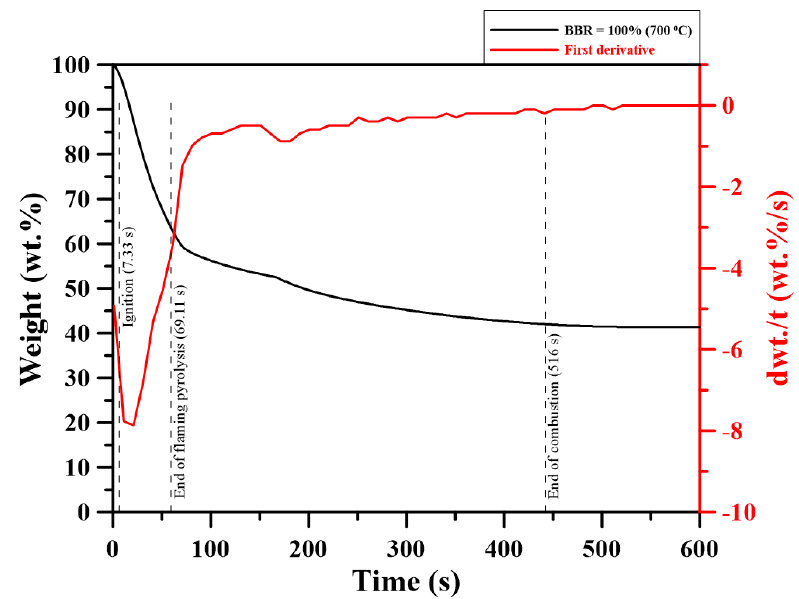
Figure 16. Weight loss history of pure sewage sludge pellet combustion process at 700 °C.